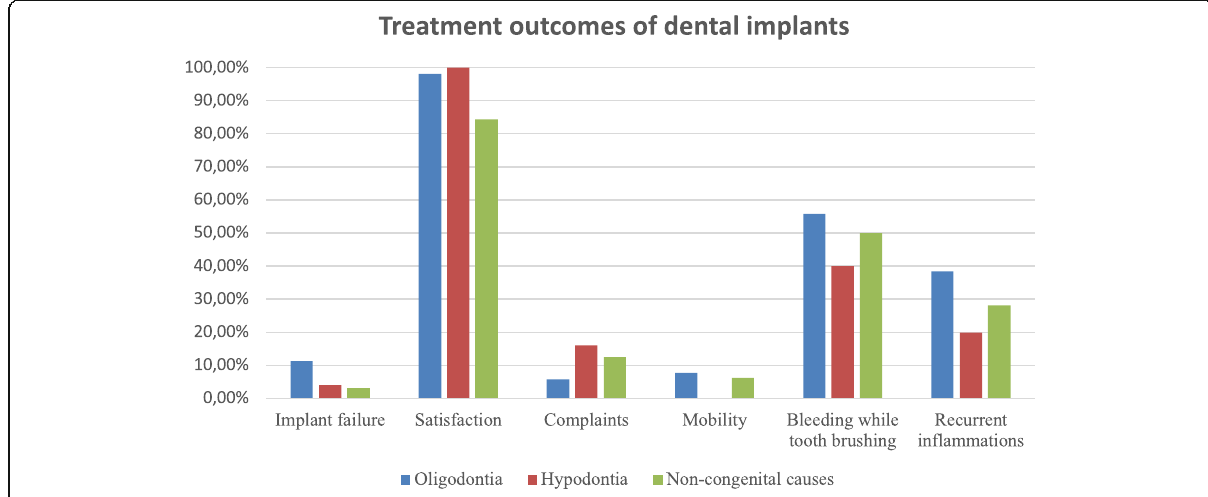
Fig. 3 Presentation of the subjective implant success. Footnote: y-axis presents the % of patients for each respective outcome between the three groups: lost implants ( p = 0.101); satisfied patients ( p=0.037 ); presence of complaints ( p = 0.505); mobility of implants ( p = 0.547); bleeding noticed during tooth brushing ( p = 0.597); presence of recurrent inflammation around the implant ( p =